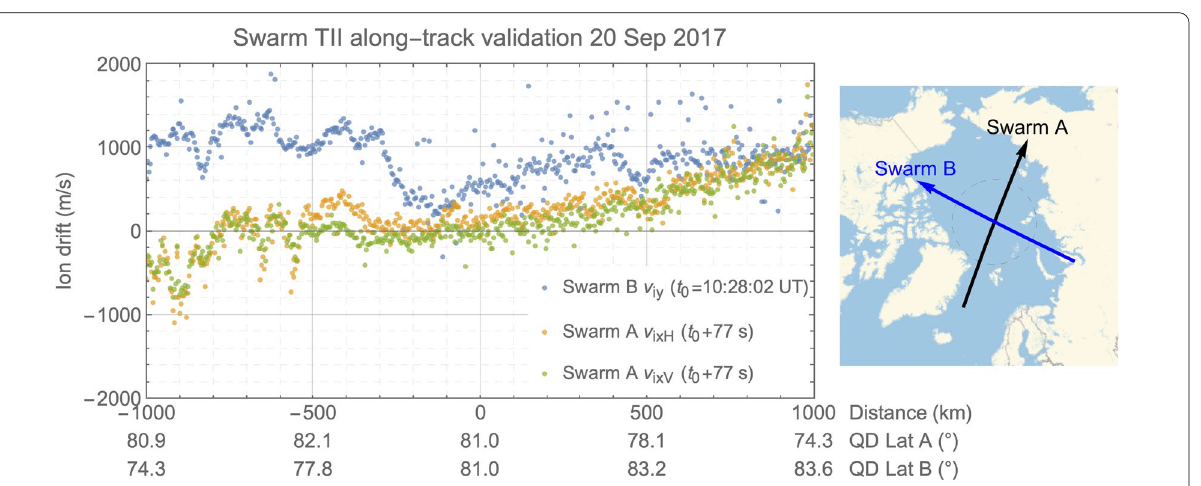
Fig. 15 Comparison of Swarm A along-track drifts with Swarm B cross-track drift during a close conjunction